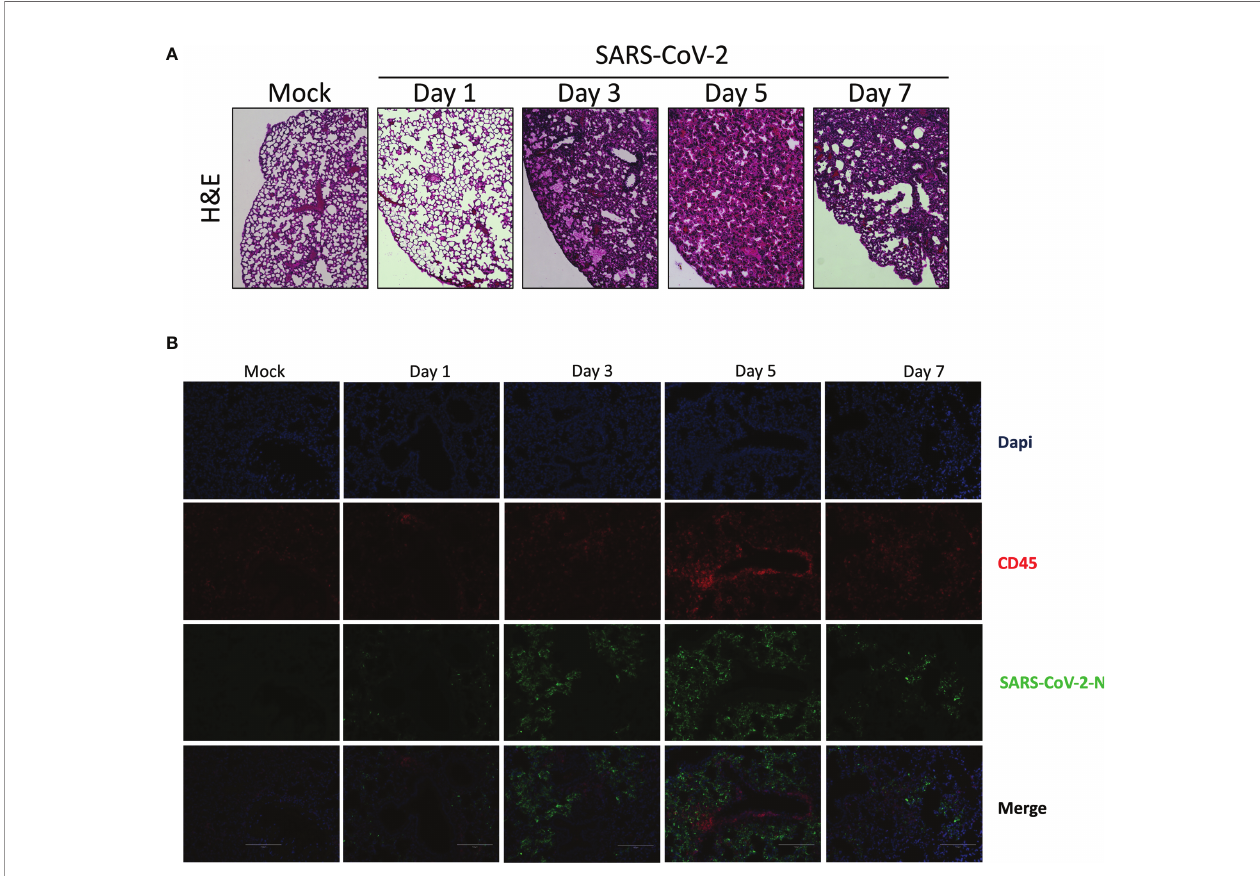
FIGURE 2 | Histological analysis of lungs of mice infected with SARS-CoV-2. Lungs of mock or SARS-CoV-2-infected mice were collected on day 1, 3, 5 and 7 post-infection. Following fi xation, lungs were paraf fi n embedded, sliced and stained with H & E (A) or analyzed by immuno fl uorescence using anti-N (green) and anti-CD45 antibodies (red) to detect SASR CoV-2-infected cells and leukocytes, respectively. (B) Nuclei were stained with DAPI. Slides were observed using an Evos M500